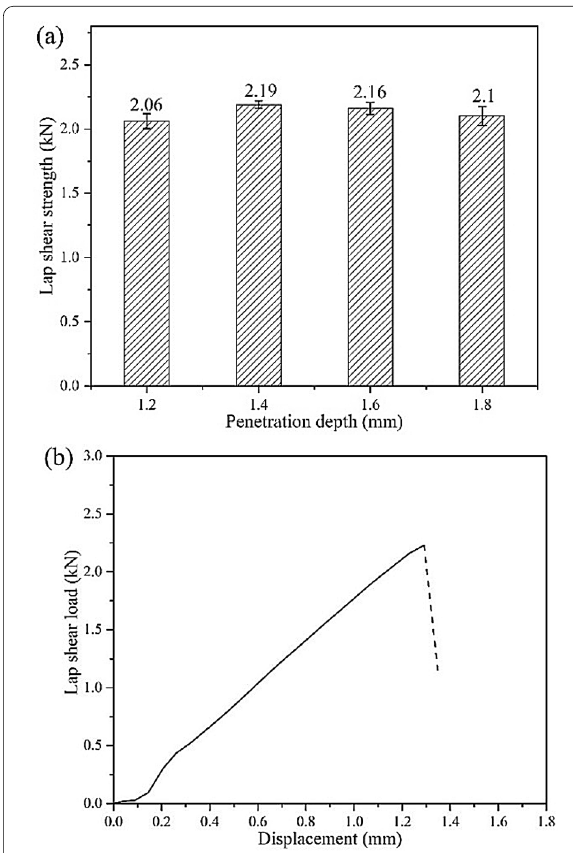
Figure 9 ( a ) relation between sleeve penetration depth and weld lap shear strength, ( b ) typical lap shear load/displacement curve of